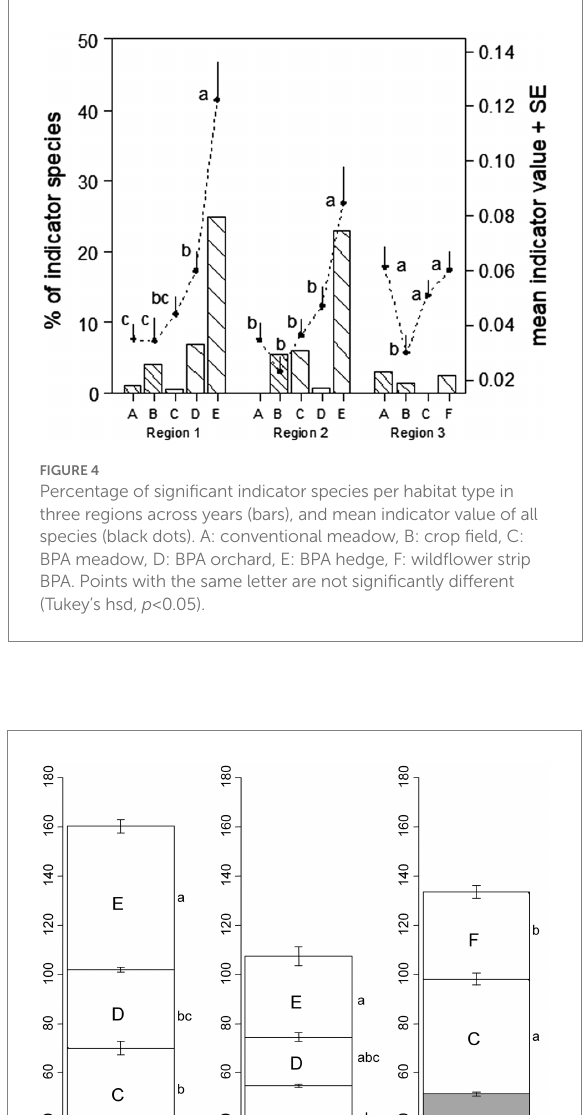
three regions although not always significant. BPA hedges in regions one and two (Figure 5E), and BPA meadows in region three showed the highest values (Figure 5C). In the three regions, conventional meadows exhibited the lowest specificity value.